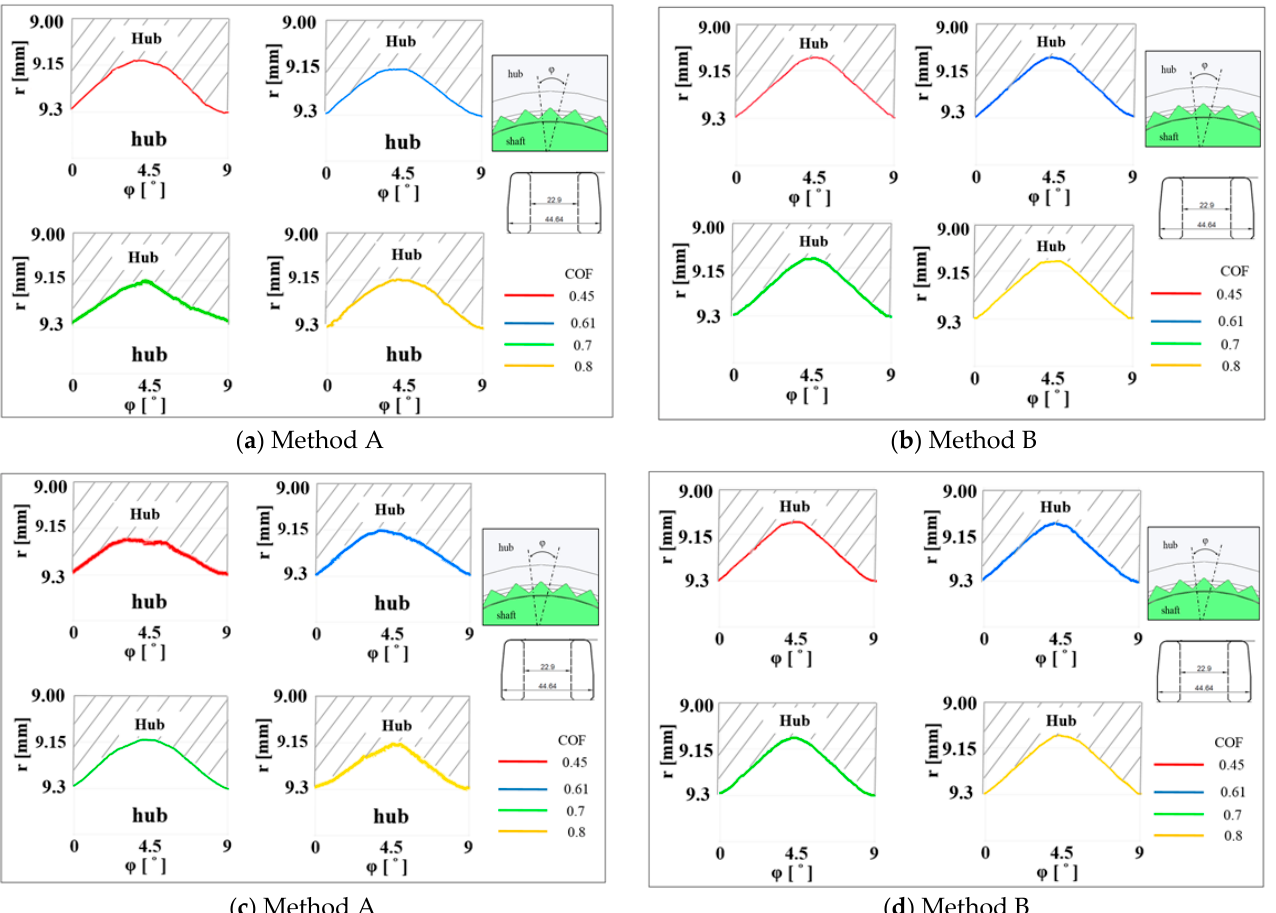
Figure 11. Tooth profile comparison of version 3 hub: ( a ) hub thickness of 10 mm in method A, ( b ) hub thickness of 10 mm in method B, ( c ) hub thickness of 15 mm in method A, and ( d ) hub thickness of 15 mm in method B.